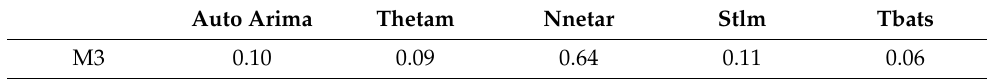
Table 4. The M3 model’s component weights for insomnia score forecasting .